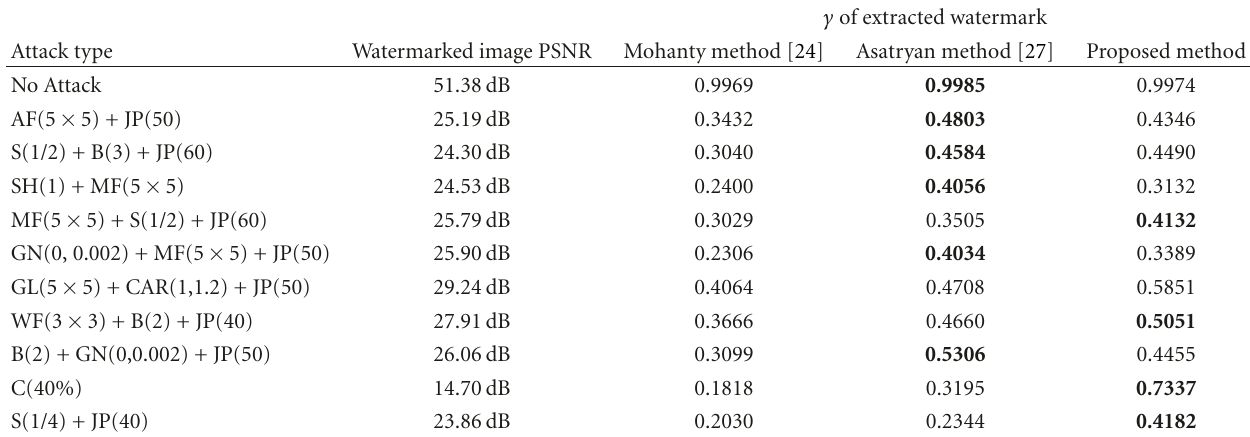
Table 10: The quality of extracted watermarked fromCrowd image (512 × 512) with watermark size 128 × 128 (Figure 11(b)) versus several attacks in di ff erent